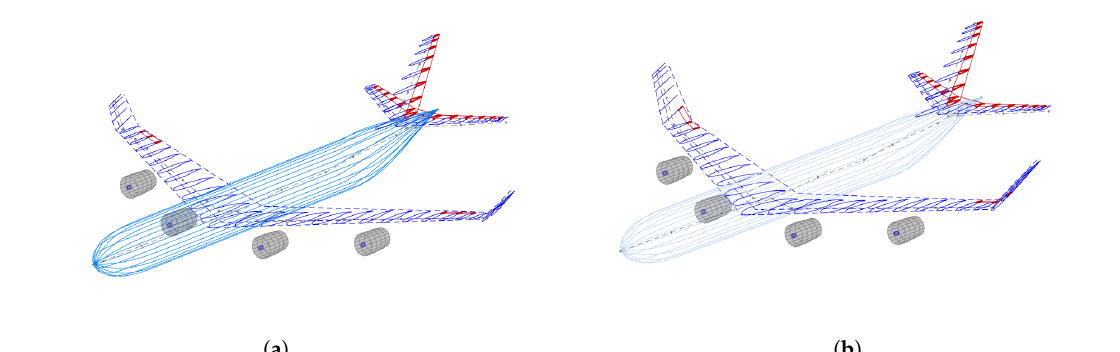
Figure 3. Discretized reduced order model representations of the AX-1 aircraft: ( a ) 2.9 m wingtip (10% semispan), 1 beam–5 aerodynamic stations wingtip; and ( b ) 5.8 m wingtip (20% semispan), 2 beam–8 aerodynamic stations wingtip.